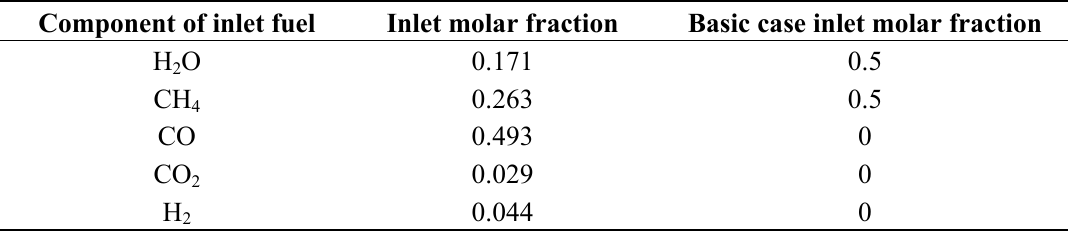
Table 1. Molar fraction of inlet fuel.